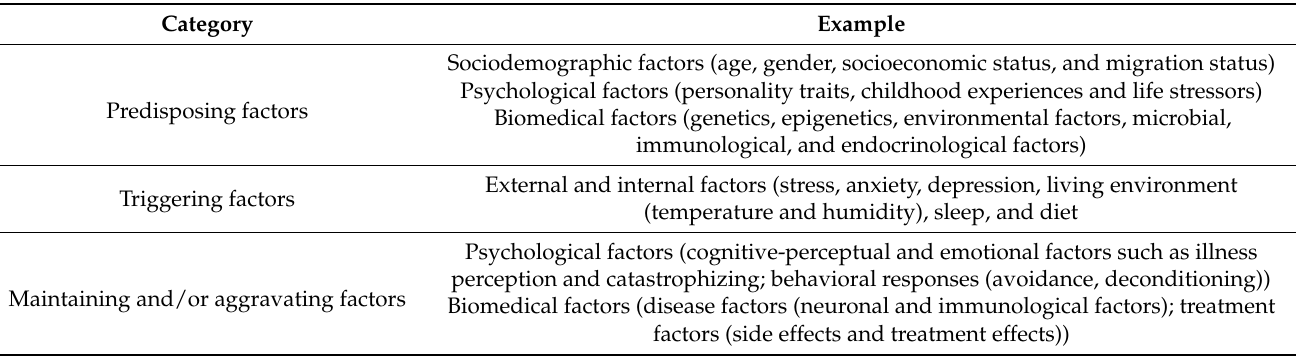
Table 2. Various factors and examples suggested to play roles in acute, chronic, and transition from acute to chronic itch.